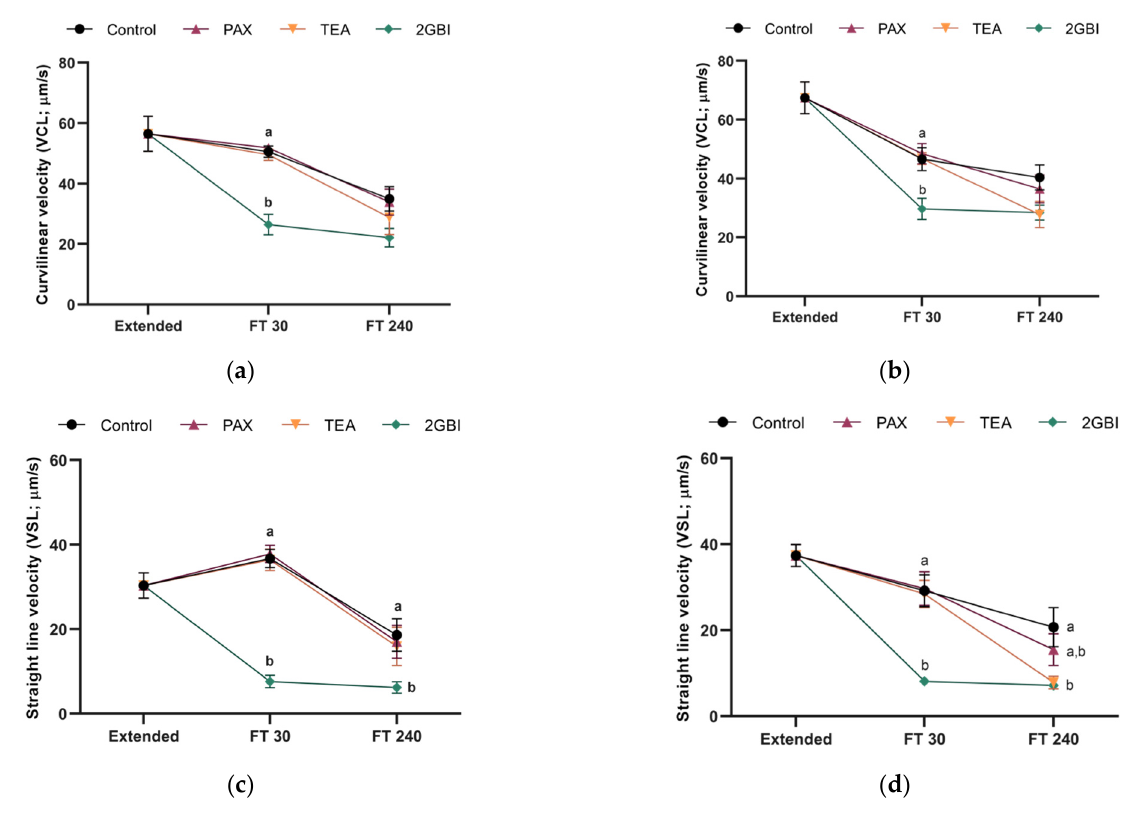
Figure 3. Curvilinear velocity (VCL; a , b ) and straight-line velocity (VSL; c , d ) in extended and frozen–thawed (FT) samples at 30 min and 240 min post-thaw. In Experiment 1 ( n = 8), TEA, PAX, and 2-GBI blockers were added to LEY medium at 15 ◦ C ( a , c ), whereas in Experiment 2 ( n = 9), they were added to LEYGO medium at 5 ◦ C ( b , d ). Different superscripts indicate significant differences ( P < 0.05) between samples within the same time point. Results are given as mean ±